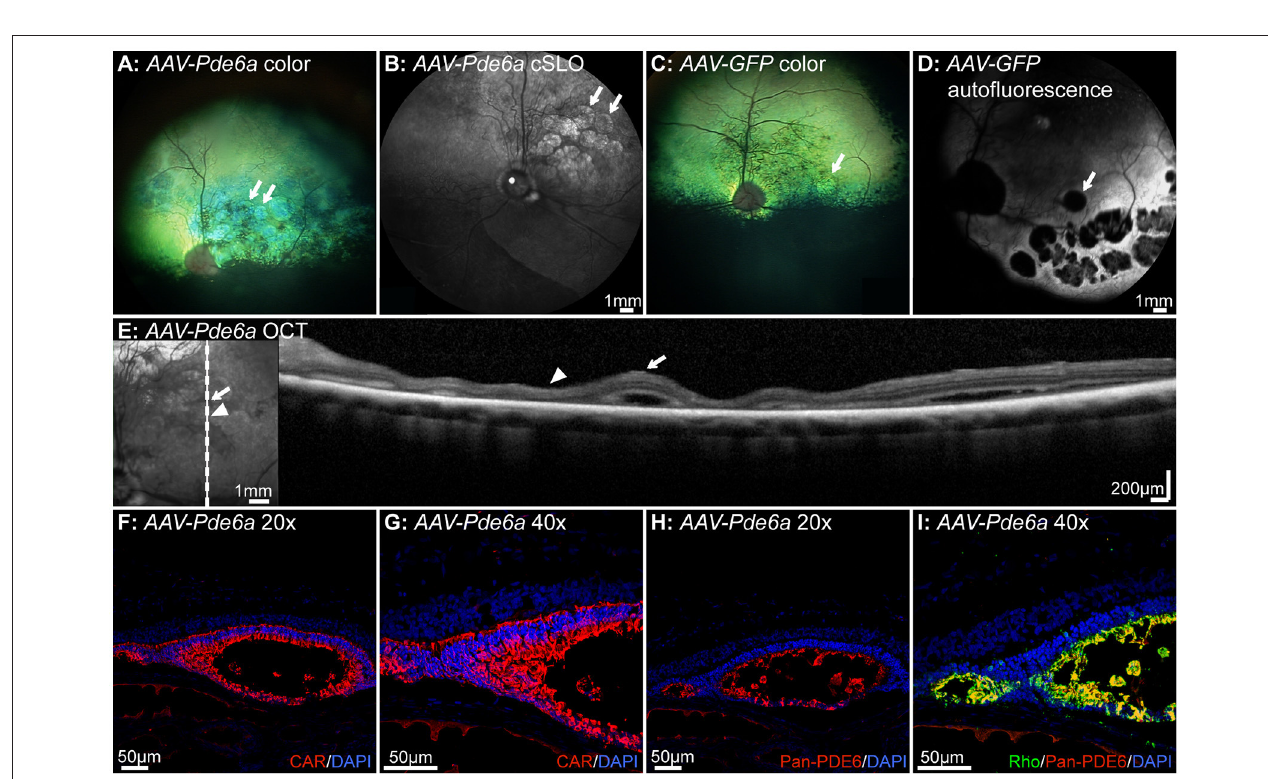
FIGURE 6 | Complications associated with gene therapy administration in Pde6a mutant dogs. In the 3 dogs injected at 41–42 days of age and injected bilaterally (one eye with AAV-Pde6a , one eye with AAV-GFP ), changes on fundus images indicating retinal thinning were observed both in eyes injected with AAV-Pde6a (A,B) and with AAV-GFP (C,D) . Eyes treated with AAV-GFP had a hyperfluorescent area delineating the injected region, and contained within that areas of focal hypofluorescence, possibly indicating loss of GFP fluorescence or cell loss (D) . White arrows delineate the corresponding areas of abnormality in (A–D) . SD-OCT imaging of these areas (E) showed foci of retinal separation (white arrow) interspersed with areas of retinal thinning, predominantly of the outer nuclear layer (white arrowhead). Histologically, the areas of retinal separation appeared to be primitive rosettes, with cone cell bodies lining a lumen (F,G) containing cone and rod outer segments expressing transgenic Pde6 (H) and endogenous rhodopsin (I) . CAR: cone arrestin, DAPI, 4 ′ ,6-diamidino-2-phenylindole; Rho,